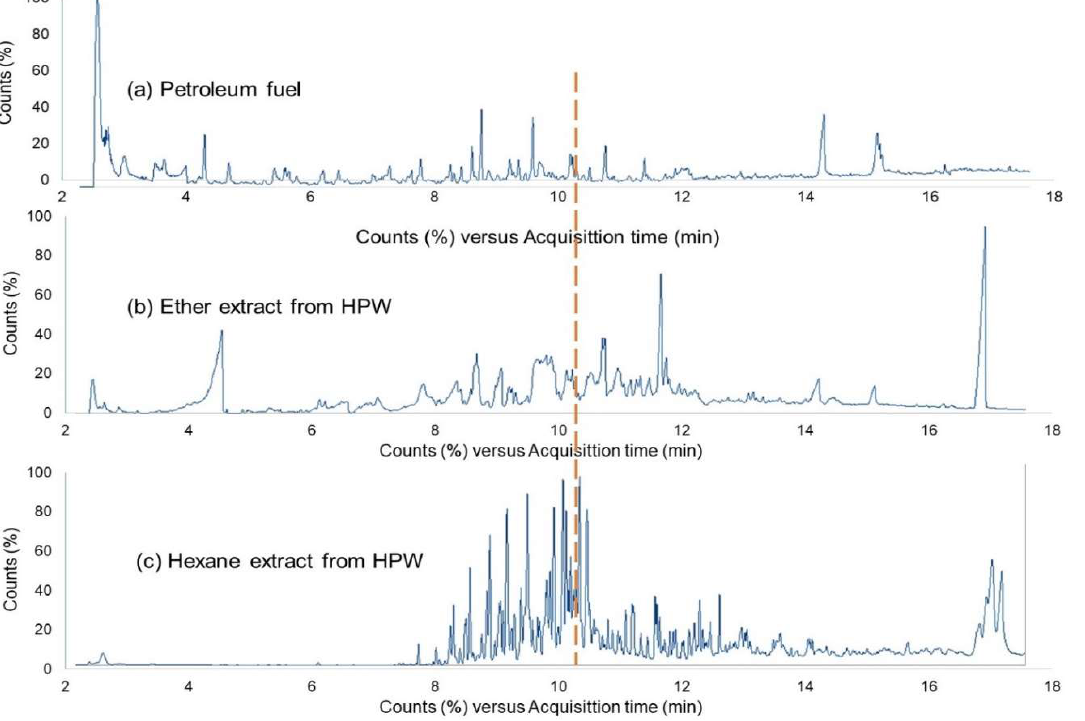
Figure 8. Comparative FTIR micrographs of ( a ) petrol, along with ( b ) ether, and ( c ) hexane extracts (ext.) from